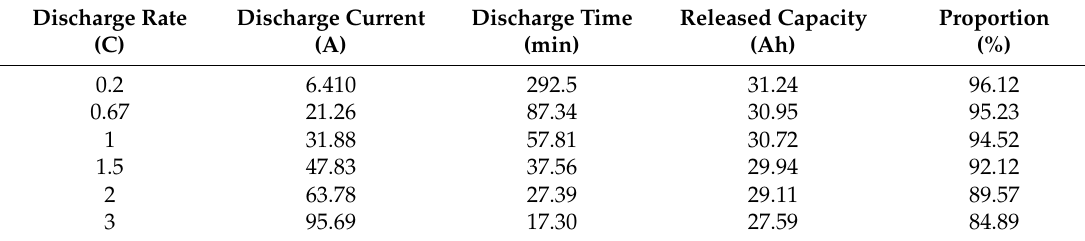
Table 2. Available capacity and discharge time at different C-rates.